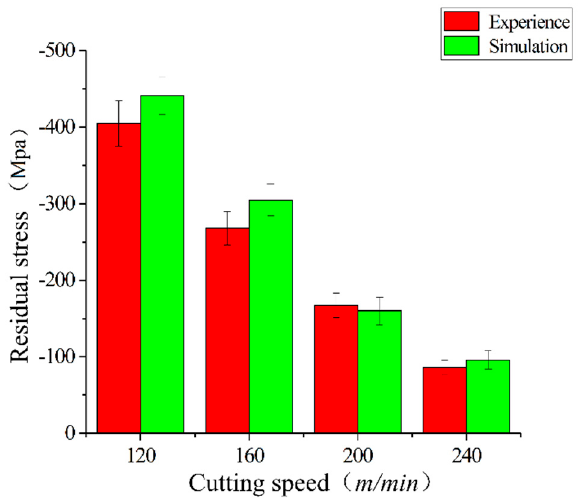
Figure 5. Test measurement of the residual stress and simulation results.